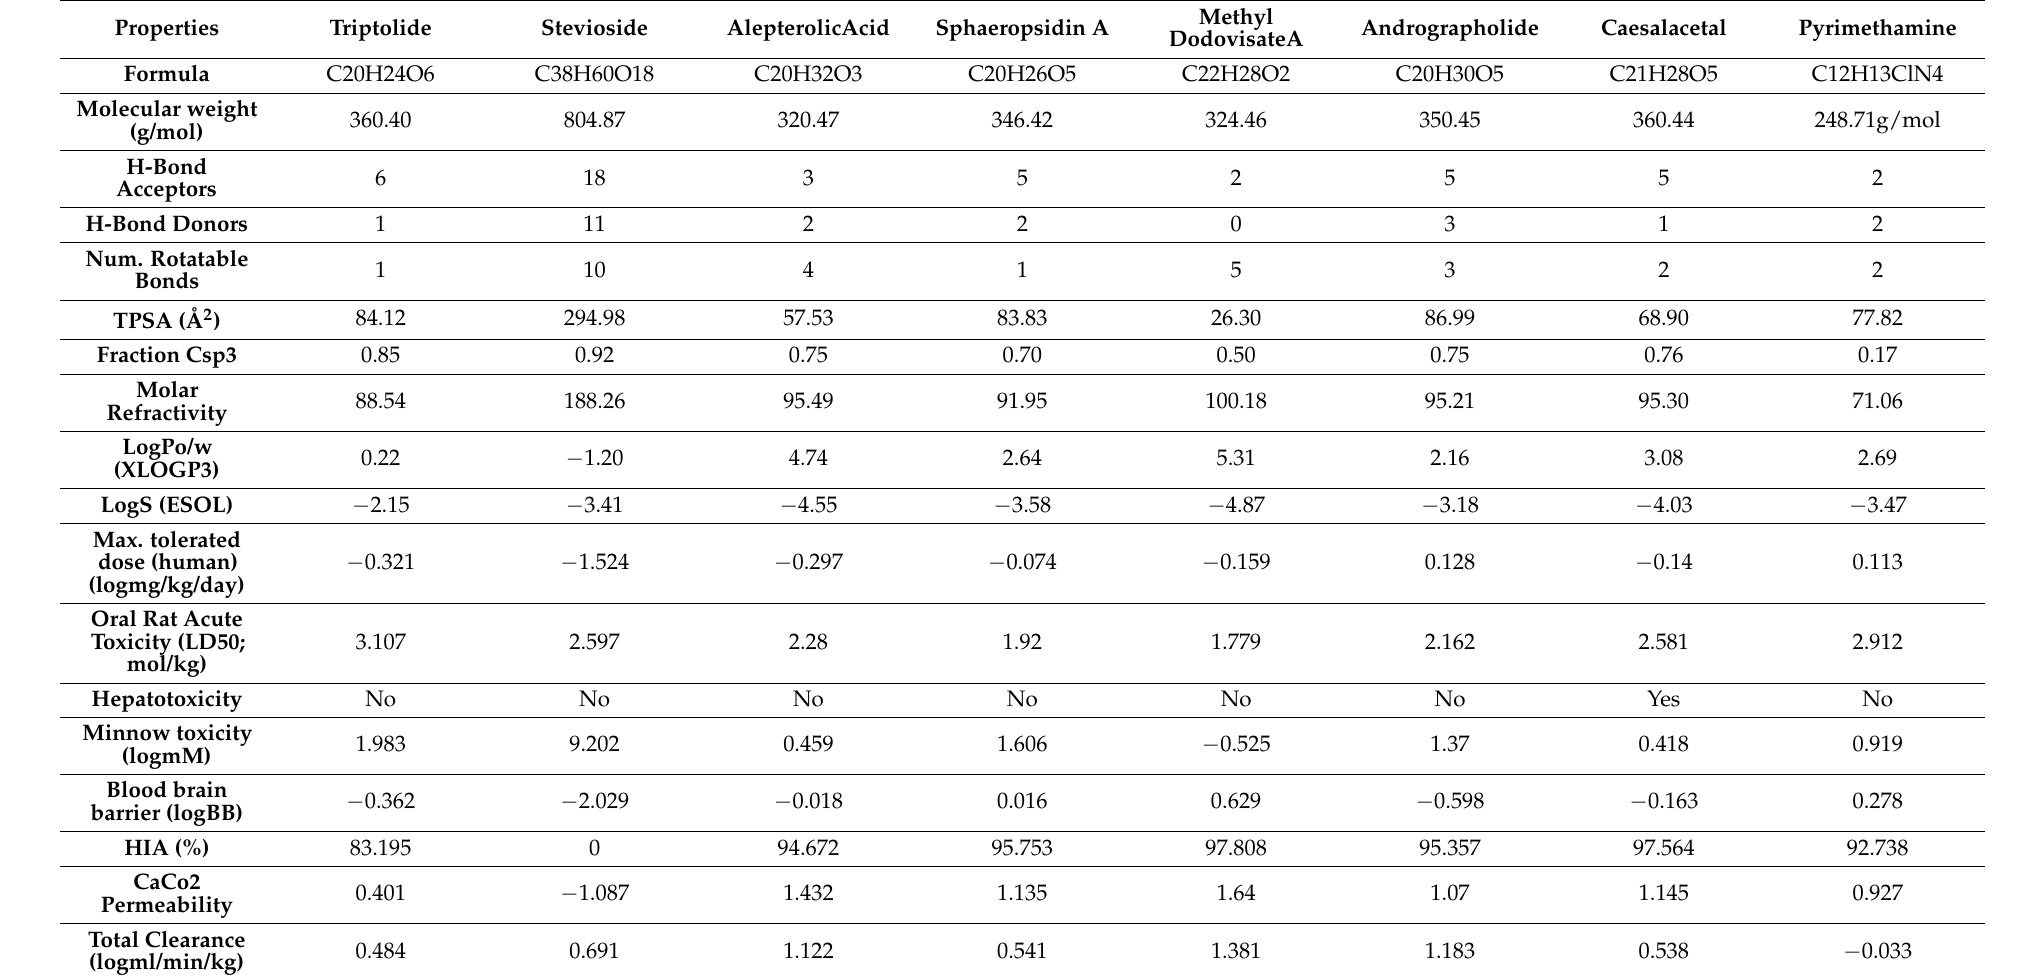
Table 1. ADMET and drug likeliness properties for